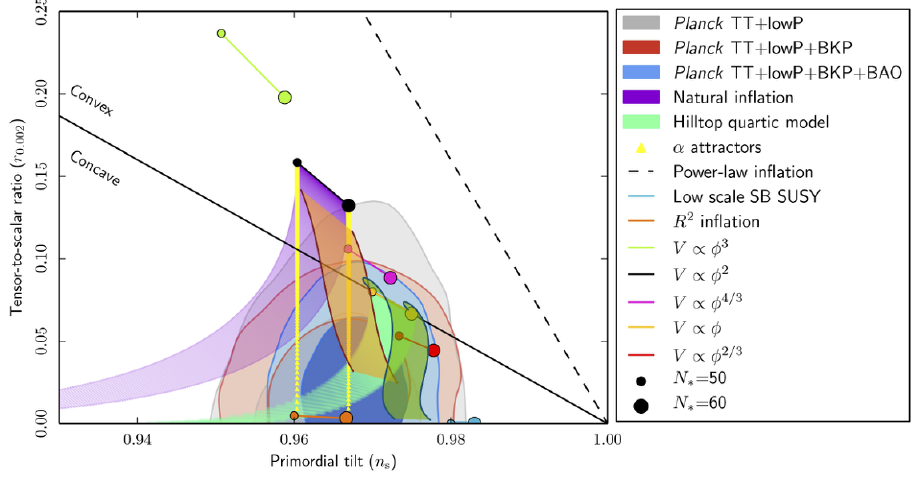
Figure 8 . Region for the spectral index n s vs. tensor-to-scalar ratio r for the two values of ^ G (orange region corresponds to ^ G = 0 : 003 and green to ^ G = 3) and 0 6 (cid:7) 6 20. exact interpolation being set roughly by ^ G ) and by increasing (cid:7) access regions with a lower value of the tensor-to-scalar ratio r . To show this more explicitly we chose to superimpose over the Planck collaboration results [45] the two regions explored in the n showing the result in (cid:12)gure